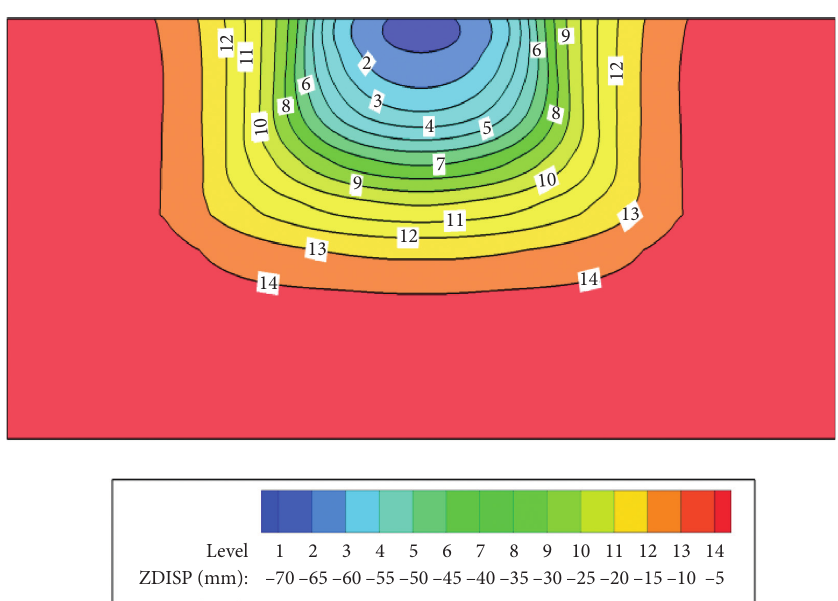
Figure 8: Contour of z -directional (vertical) displacement at the section of y � 0.